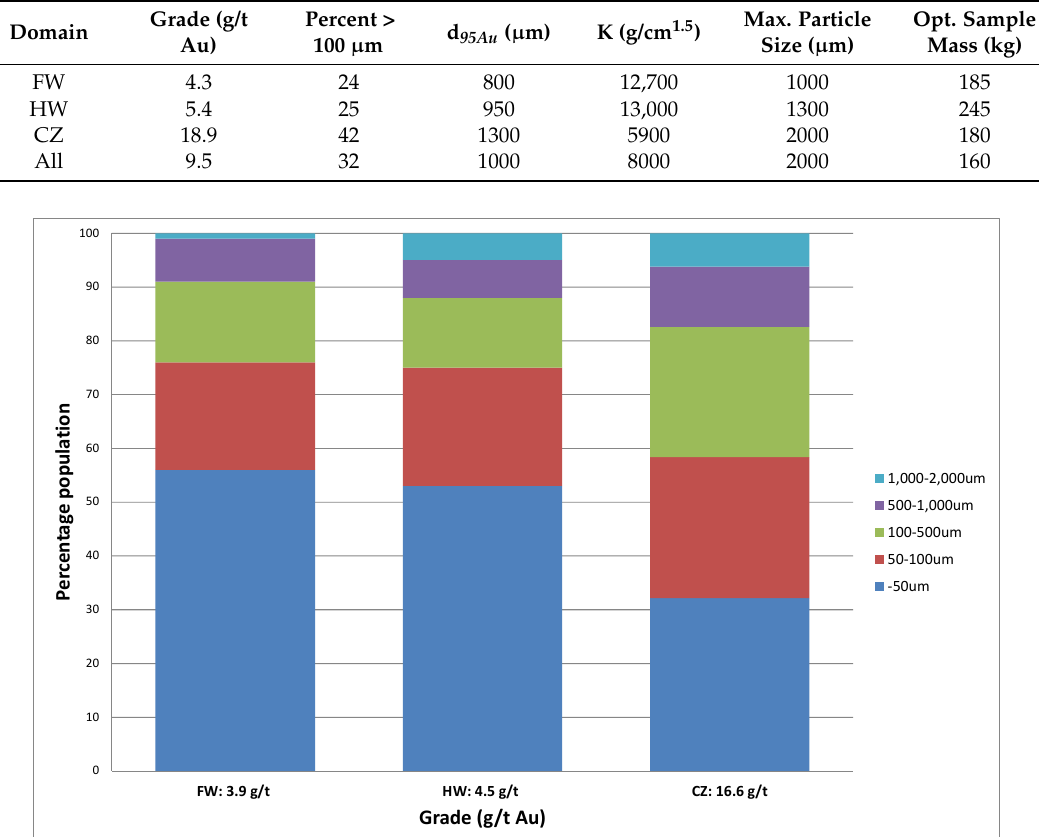
Figure 6. Percentage gold particle distribution (by mass) for SVZ mineralisation domains based on bulk sample processing.